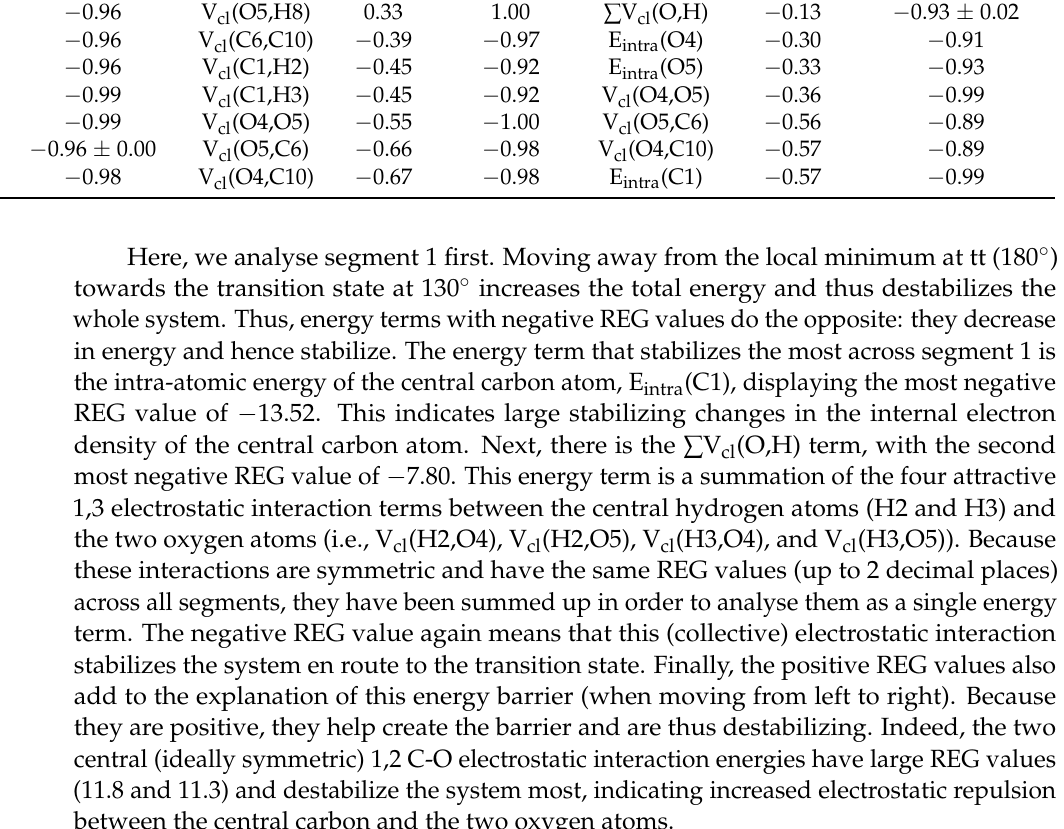
Table 1. In summary, the anomeric effect is dominated by electrostatic and steric effects, as can be seen from their REG values across segments 1 and